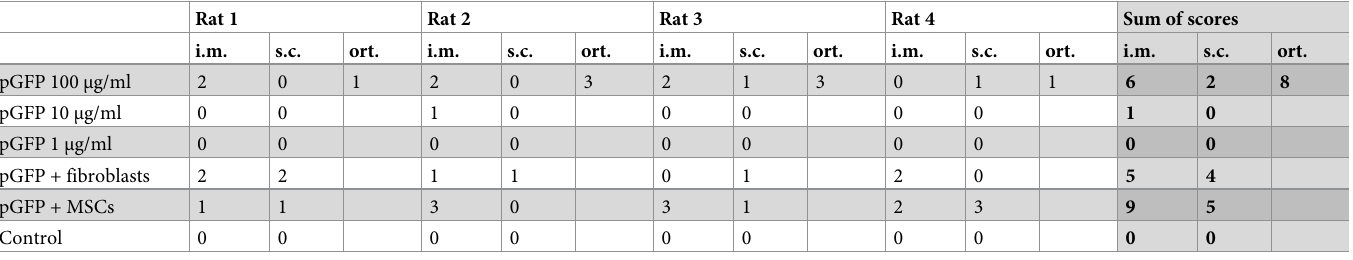
Fig 3. Qualitative imaging of in vivo gene expression. A representative image of the GFP immunohistochemistry (in red) for each group implanted in the subcutaneous (left column panels), intramuscular (middle panels) or orthotopic (right panel) locations. Each row represents an experimental group, as outlined in Table 2. Nuclei are DAPI stained (in blue). Scale bar = 100 μ m for all panels.